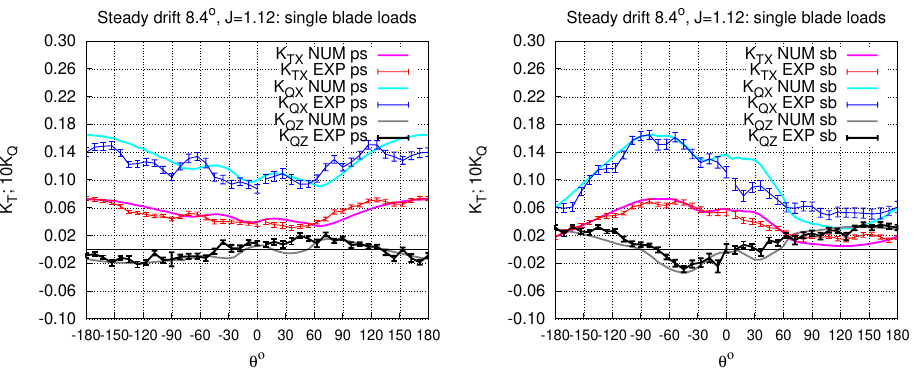
Figure 12. Propulsive performances of the model hull in ahead motion at 8.4 ◦ drift angle, J = 1.12: single blade contribution to thrust, torque and spindle moment coefficients. ( Left ) portside propeller. ( Right ) starboard